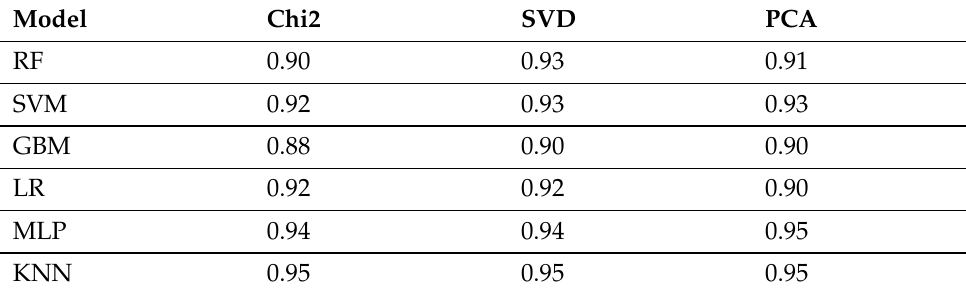
Table 6. Performance of classifiers with 10 most important features.